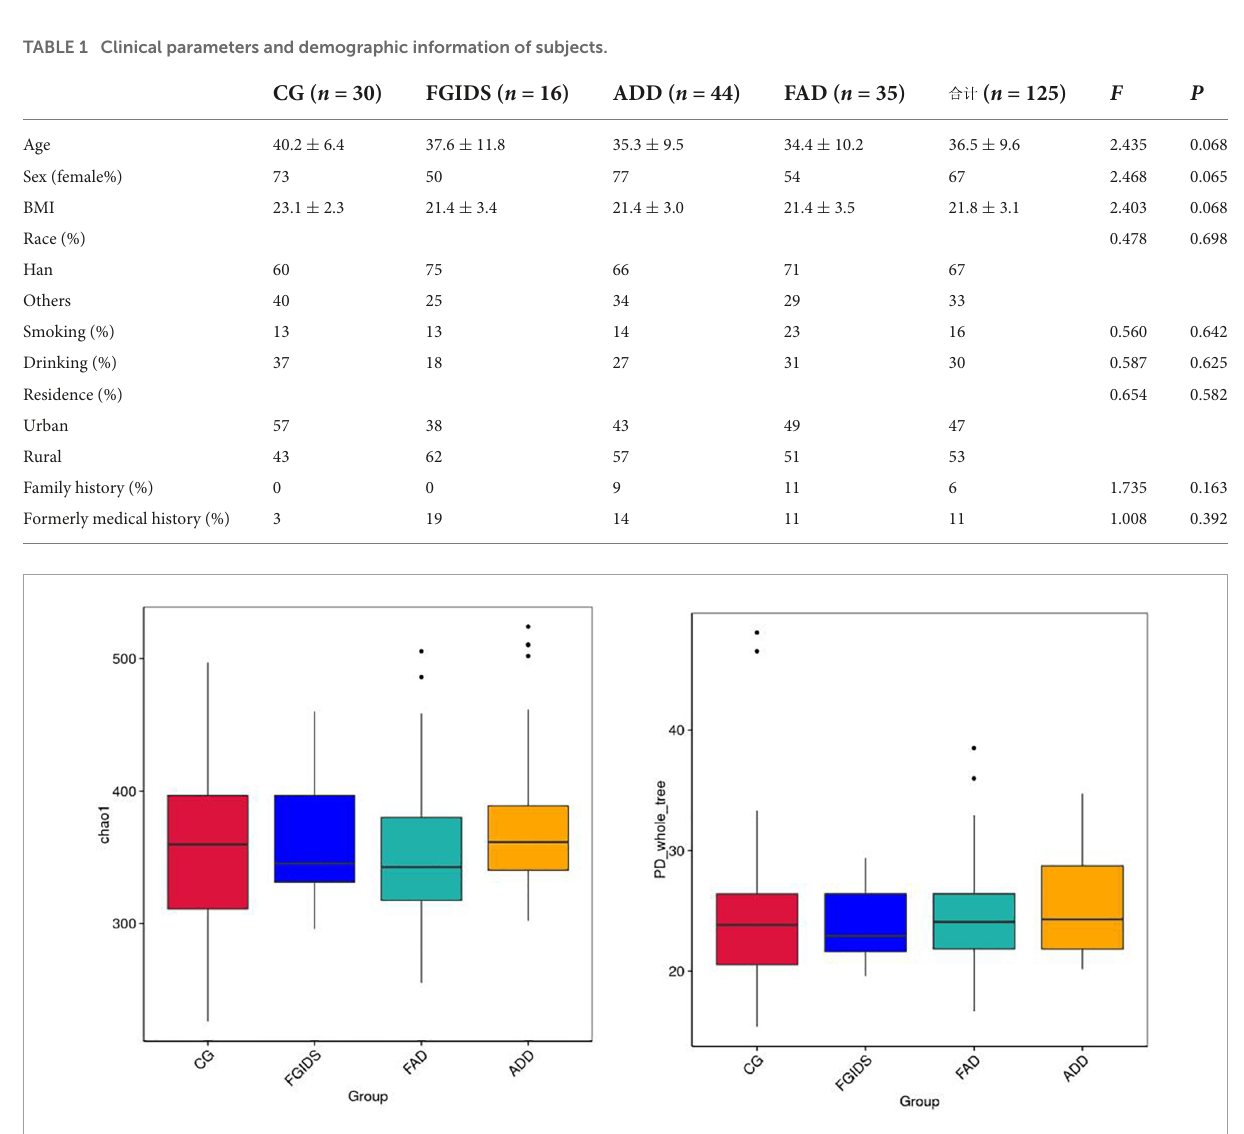
FIGURE1 Analysis chart of α diversity of intestinal flora among different